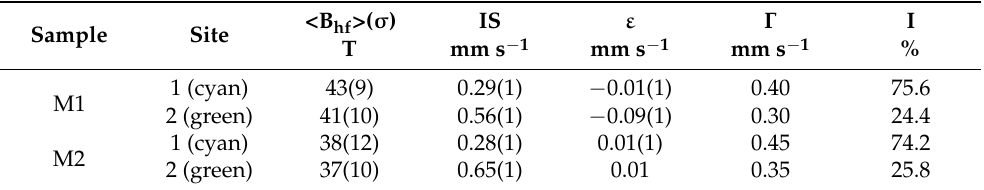
Figure 4. ( a ) Mossbauer experimental spectra (open circles) and fitted curves (blue lines) for samples synthetized with the aid of gelatin (M–g), Pectigel (M–p) and agar-agar (M–a) additives. Cyan and green lines correspond to the contributions of the magnetic hyperfine interactions in sites 1 and 2, respectively, associated with different oxidation states of iron. The corresponding distributions of the magnetic hyperfine fields are plotted in ( b ), using the same colours. For M–p, the component fitted with a quadrupole doublet is drawn with an orange line and is associated with a superparamagnetic behavior of the smaller NP. Table 4. Mössbauer hyperfine fitting parameters for NP M1 and M2. <B hf >( σ ): average magnetic hyperfine field and standard deviation of magnetic field distribution; IS: isomer shift; ε : quadrupole shift; Γ : Lorentzian line width; I: relative area. Uncertainties in I are less than